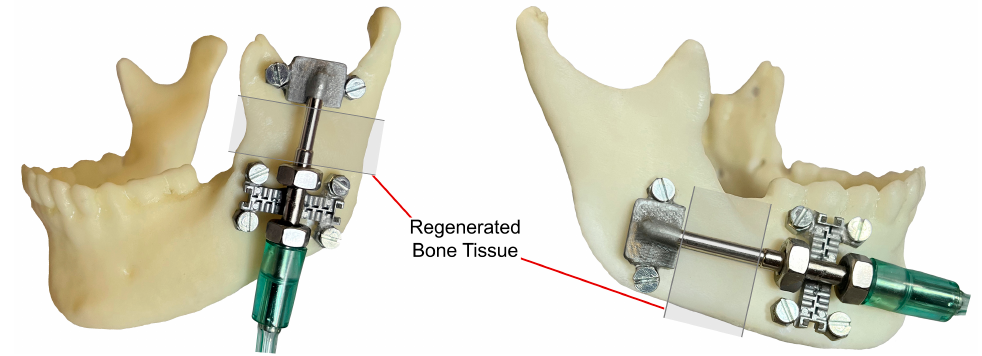
Figure 11. Illustration of the application of intra-oral bone-borne end effector in MRA.